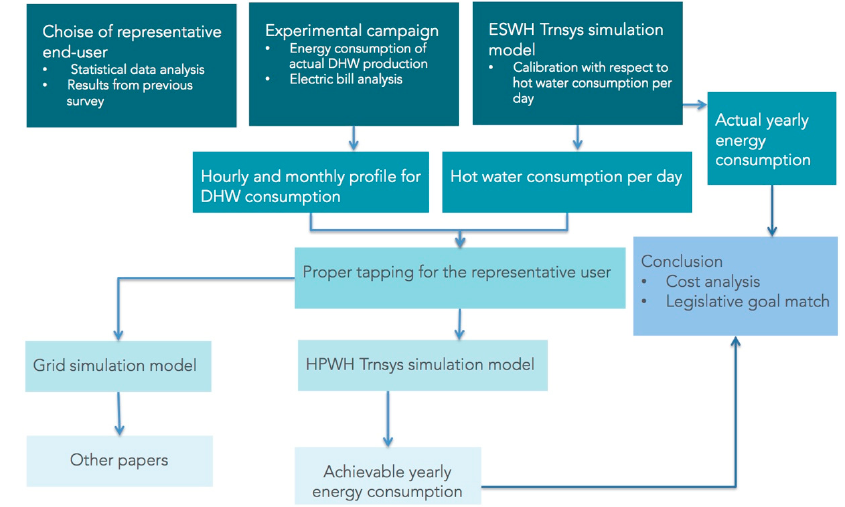
Figure 1. Workflow of the presented work.